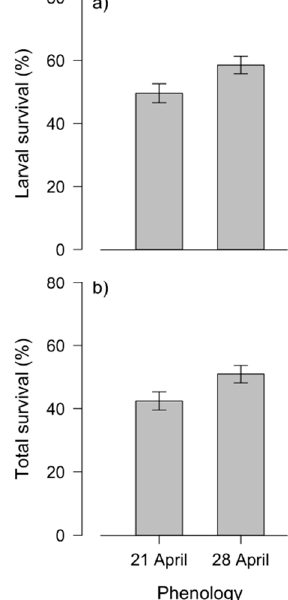
Figure 3. Influence of spring phenological synchrony between the date of emergence of eastern spruce budworm and of budburst of white spruce trees on mean ( ± SE) survival ( a ) to pupation (i.e., larval survival) and ( b ) to adult emergence (total survival) on white spruce trees. Second-instar larvae were placed on 28 trees approximately one (28 April 2012) or two (21 April 2012) weeks before budburst.